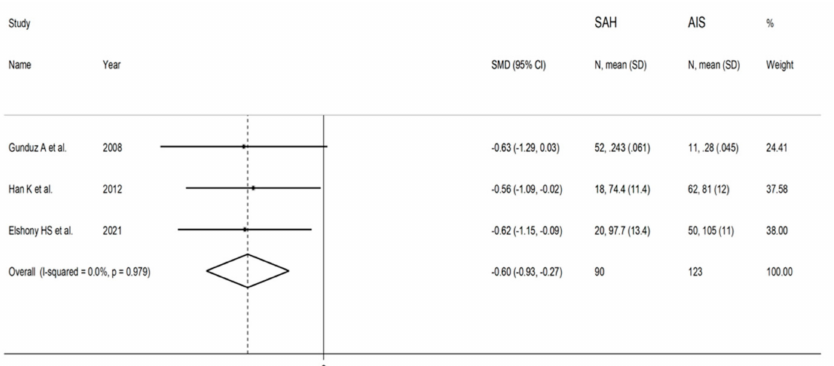
Figure 13. Forest plot of studies examining ischaemia-modified albumin in patients with subarach- noid haemorrhage and acute ischaemic stroke.